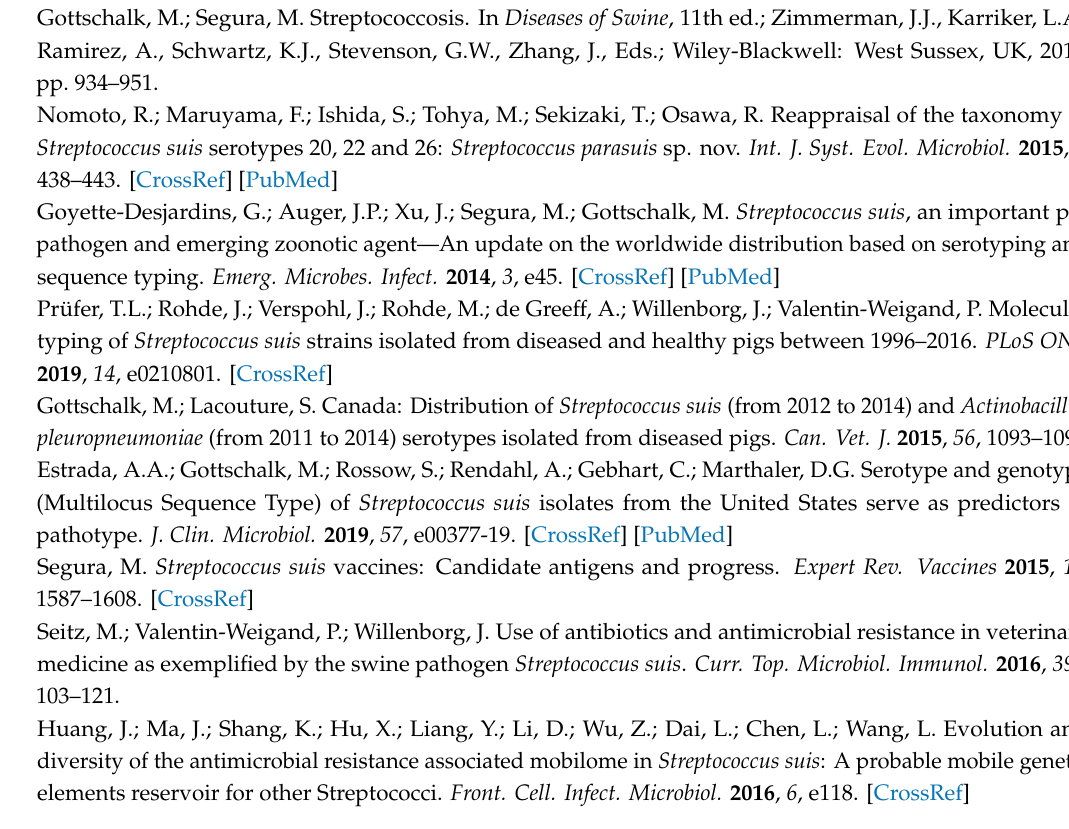
Figure S1: Correlation between IgM levels and % of killing at 5 weeks of age in the vaccinated piglet group. Blood samples were collected from randomly chosen (and tagged) piglets at 5 weeks of age from 50 vaccinated animals to evaluate IgM titers and opsonophagocytosis assay (OPA) activity. A p value < 0.05 indicates a positive